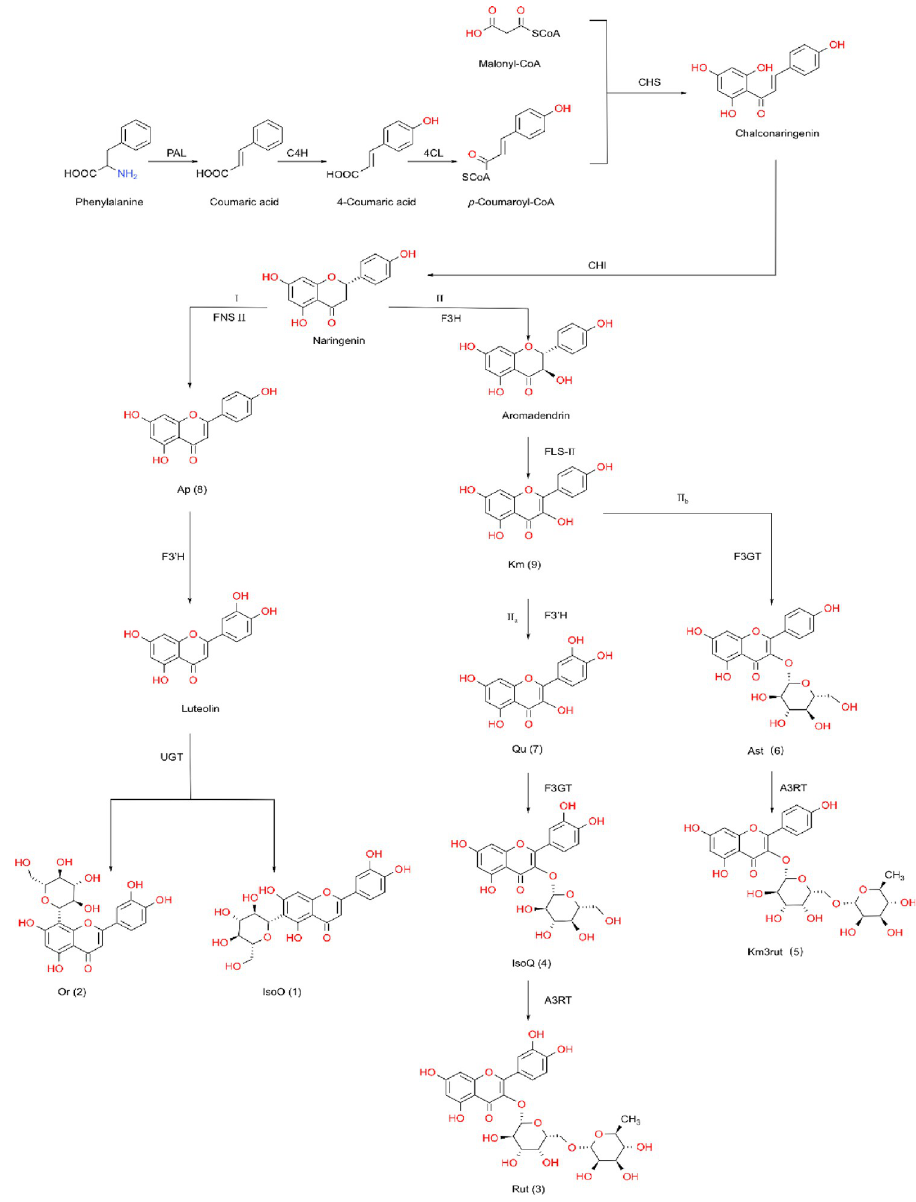
Fig 3. A schematic outline of flavonoid pathway proposed for T . hemsleyanum . PAL, phenylalanine ammonia- lyase; C4H, trans-cinnamate 4-monooxygenase; 4CL, 4-coumarate-CoA ligase; CHS, chalcone synthase; CHI, chalcone isomerase; FNS II, flavone synthase II; F3 0 H, flavonoid 3 0 -hydroxylase; F3H, flavonone 3-hydroxylase; FLS- Ⅱ , flavone synthase Ⅱ ; UGT, UDP-glucosyltransferase; F3GT, flavonol-3-O-glucosyltransferase; A3RT, anthocyanidin-3-O- glucoside-6-O-rhamnosyltransferase. 3’,4’5,7-tetrahydroxyflavone (luteolin, Lu), which is rapidly glycosylated by UDP-glucosyl- transferase (UGT) to form a pair of competitive isomers: Or and IsoO. Along Path II, the as- formed aromadendrin is first dehydrogenated by flavone synthase II (FLS-II) into 4’,5,7-trihy- droxyflavonol (Km) and then branched into two parallel sub-routes, including path IIa that produces Qu, IsoQ, and Rut in series and path IIb that produces Ast and Km3rutin.